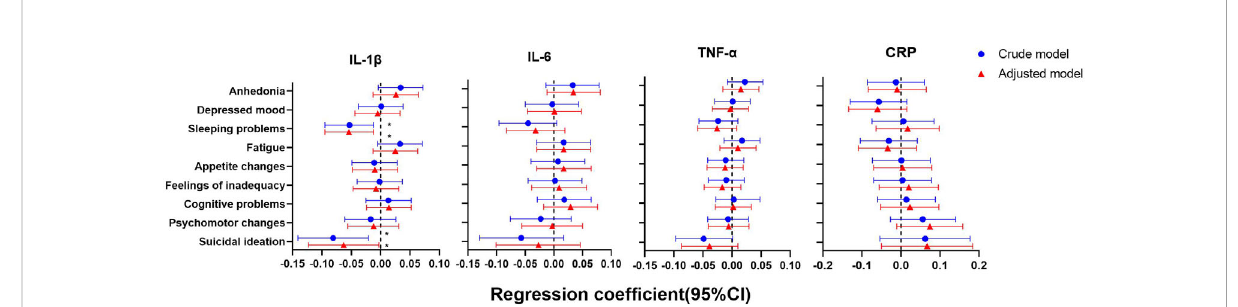
FIGURE 4 Generalized linear models of the associations between symptom-speci fi city of depressive symptoms and in fl ammatory biomarkers at baseline (n=723). IL-1 b , interleukin-1 b ; IL-6, interleukin-6; TNF- a , tumor necrosis factor- a ; CRP, C reactive protein. a The blue plot represented the crude model which was not adjusted by any variables, and the red plot represented the adjusted model which was adjusted by residential area, self-reported family economy, self-rated health condition, father ’ s education level, mother ’ s education level, cigarette use and alcohol use.